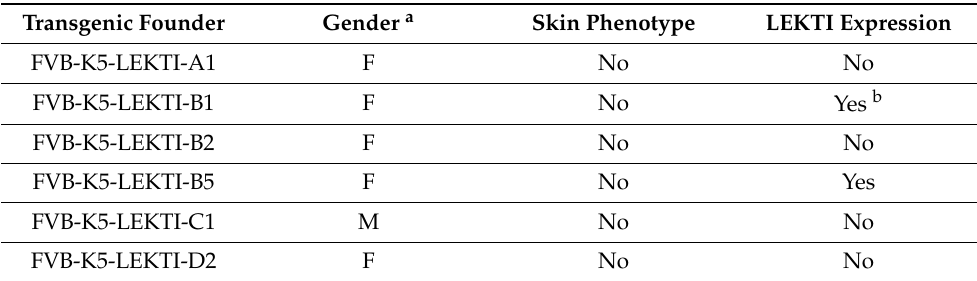
Table 1. Generation of Keratin5-LEKTI transgenic